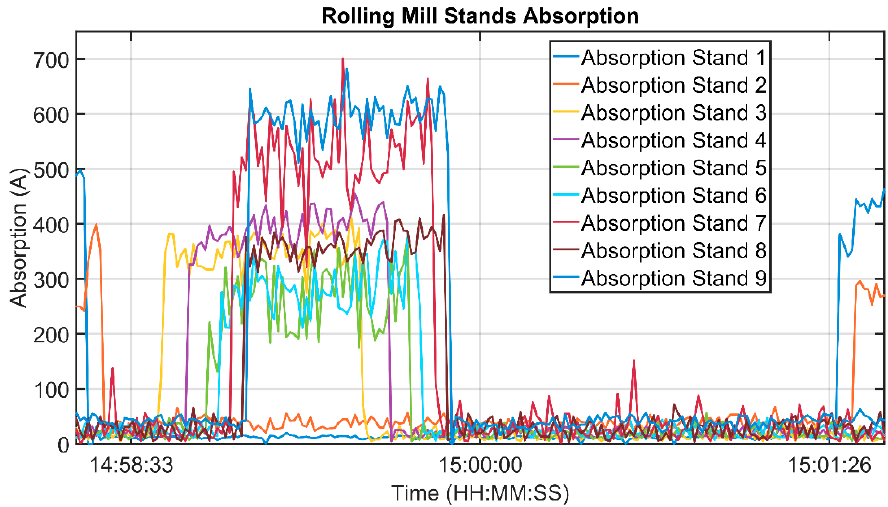
Figure 7. Rolling mill stands’ absorption measurements.